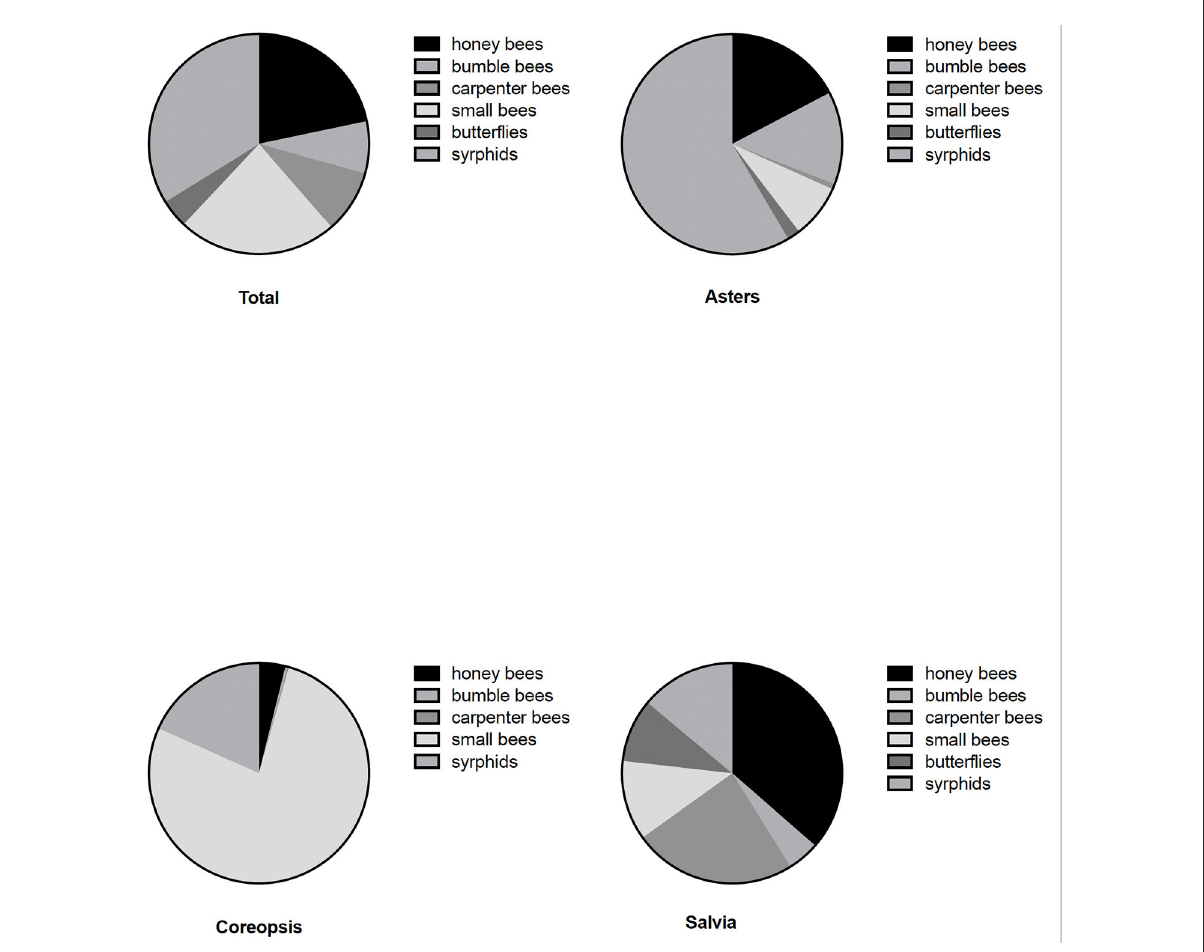
FIGURE4 Relative abundance of insects in six main groups (legend moves clockwise in each figure) recorded over 2 years at the University of Georgia Research and Education Garden on asters, salvia and coreopsis. More detailed taxonomic breakdowns of bee species are given in Table